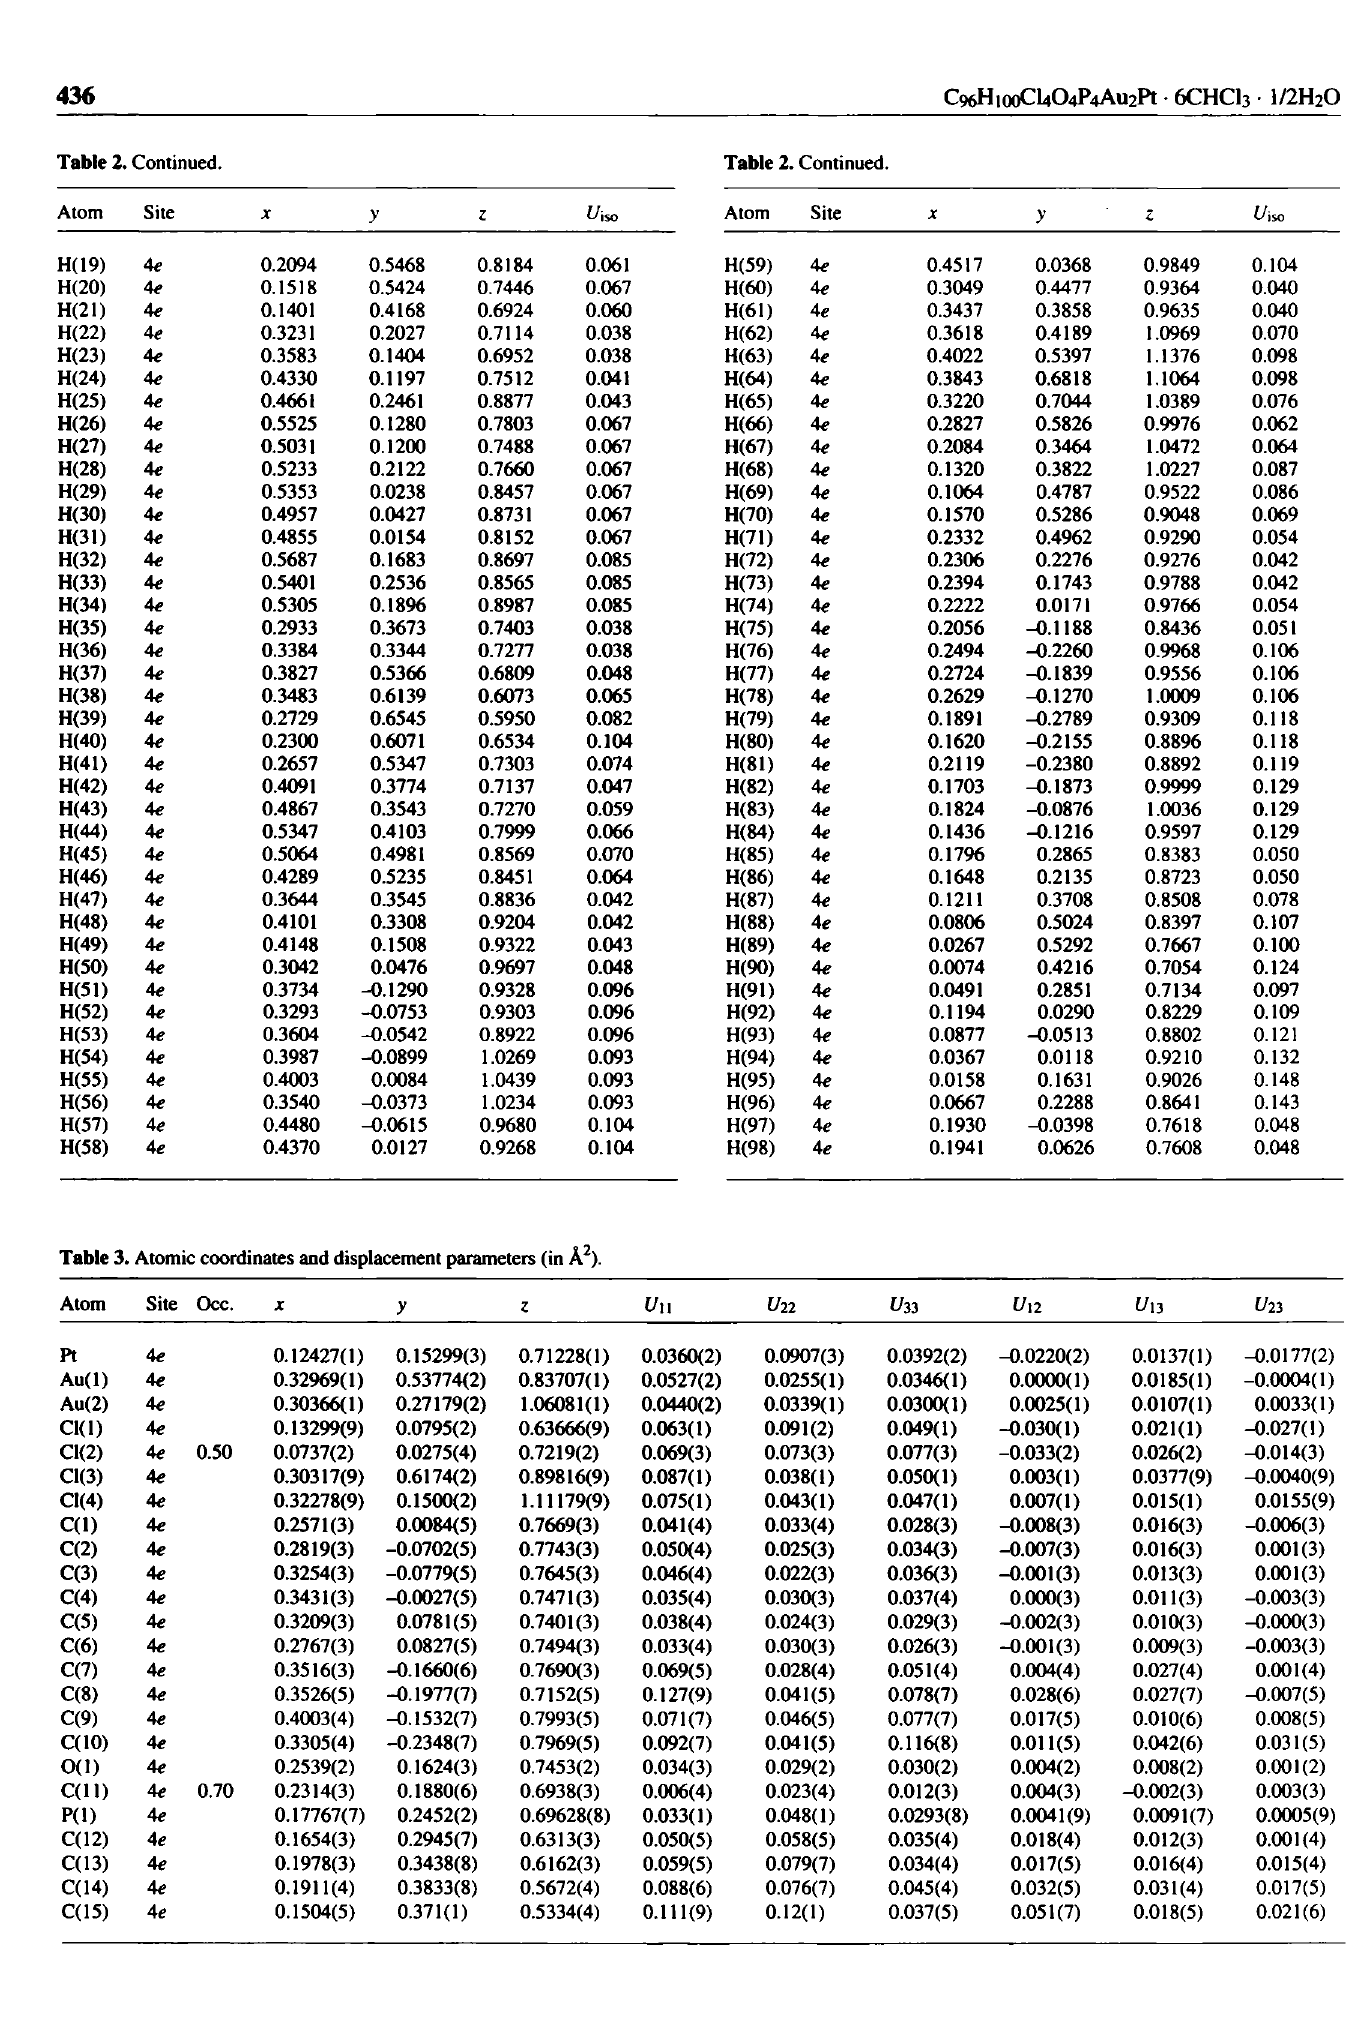
Table 3. Atomic coordinates and displacement parameters (in Ä 2